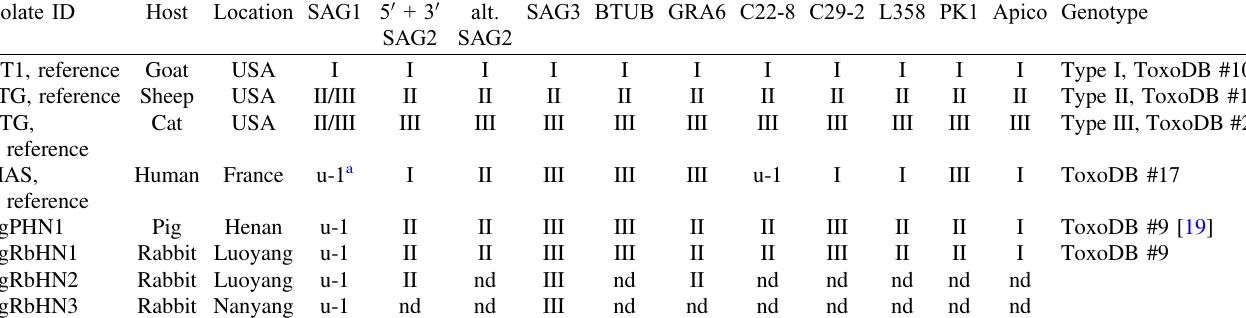
Table 2. Multilocus genotyping of Toxoplasma gondii from domestic rabbits in Henan Province, central China. Isolate ID